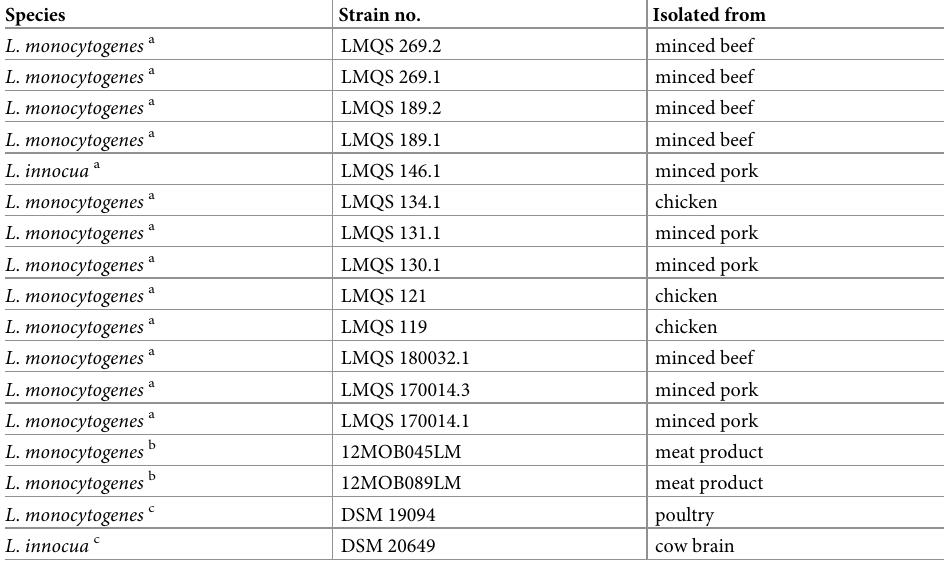
Table 2. Listeria spp. strains tested for sensitivity towards enriched crude bacteriocin preparations from Pediococ- cus acidilactici LMQS 154.1 and Pediococcus pentosaceus LMQS 331.3 cell-free